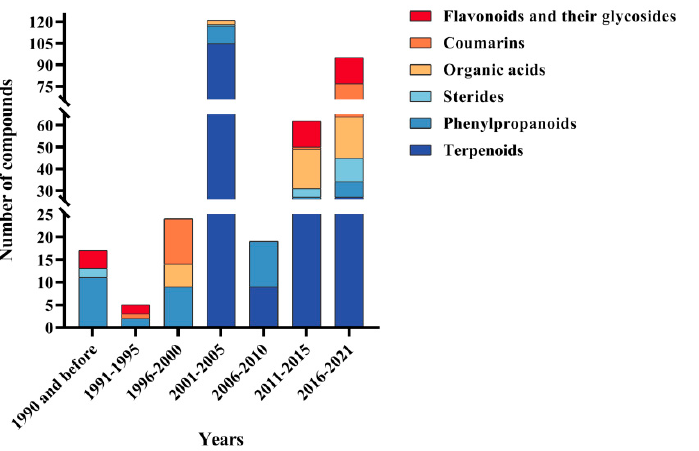
Figure 2. The number of different types of compounds identified from genus Pimpinella in different